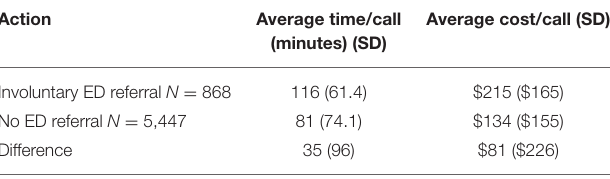
TABLE 4 | Average time (minutes) and cost per call: Involuntary referral vs. No ED referral.